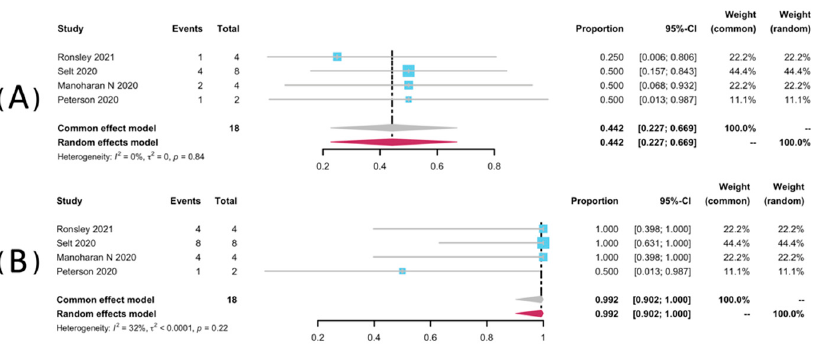
Figure 4. Forest plots for the objective response rate ( A ), and the disease control rate ( B ) in LGGs patients receiving trametinib.